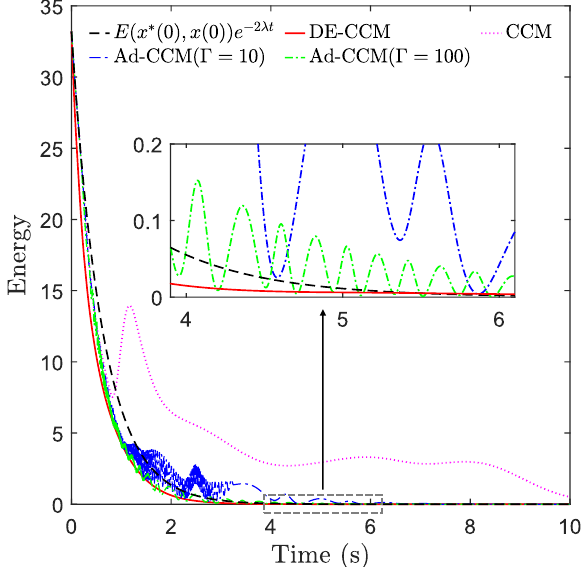
Figure 6. Riemannian energy under different controllers. E 0 (cid:44) E ( x (cid:63) ( 0 ) , x ( 0 )) .